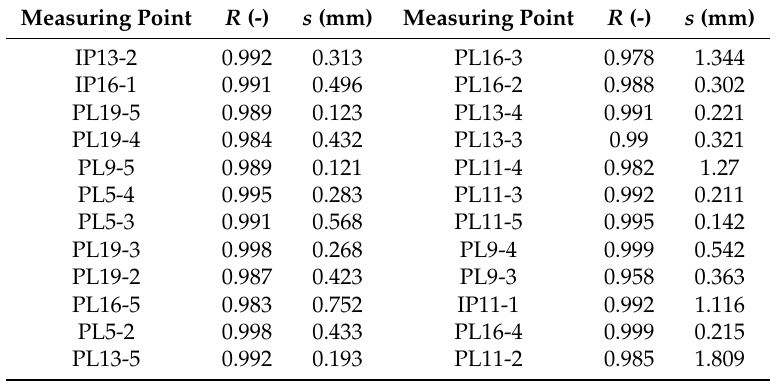
Table 2. Correlation coefficient R and residual standard deviation s of each measuring